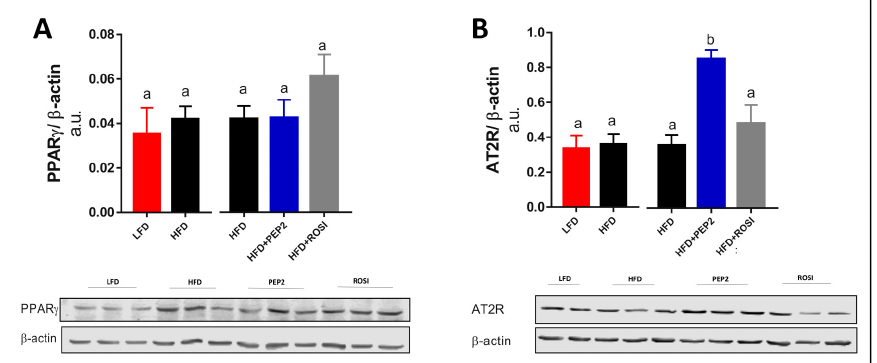
Figure 6. Liver protein abundance in tissues harvested from mice treated with Peptide 2 (Protocol 2). ( A ) PPAR γ protein abundance and ( B ) AT2R. Data expressed as mean ± SEM of n = 5–6 mice. Data analyzed by two-tailed t-test (LFD vs. HFD) and by one-way ANOVA or Kruskal-Wallis (HFD groups). Bars with different letters indicates p < 0.05. PPAR γ , peroxisome proliferator-activated receptor gamma; AT2R, angiotensin II type 2 receptor.